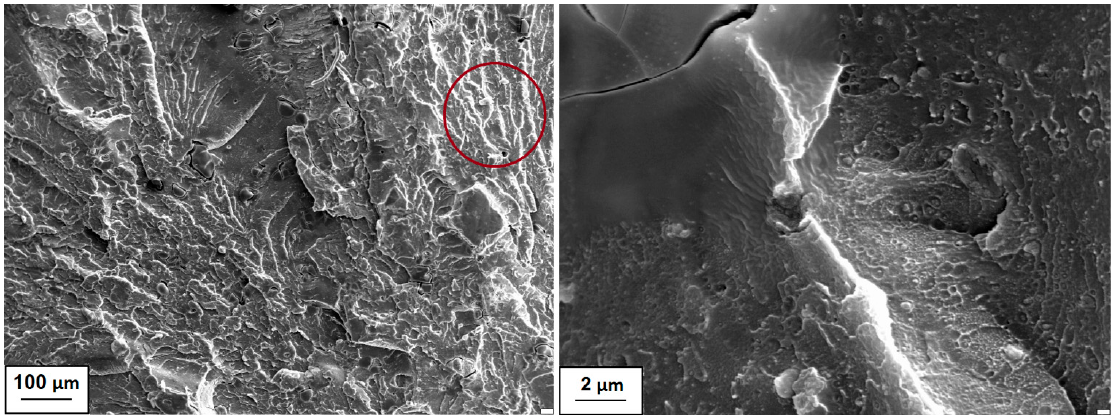
Figure 12. SEM images of PVC/silica–lignin composite with 7.5 wt % filler content (area marked with a circle shows the PVC layered structure).